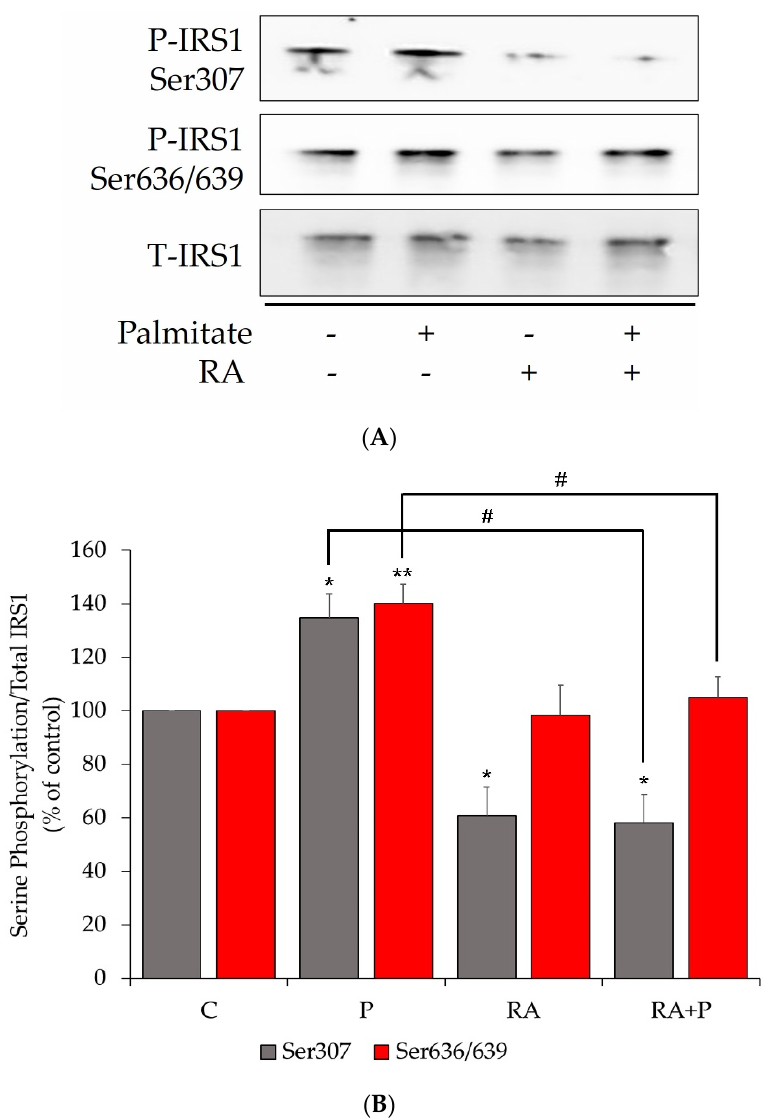
Figure 1. Rosmarinic acid attenuates the palmitate ‐ induced serine (Ser307 and Ser636/639) phosphorylation of muscle cell IRS ‐ 1. Fully differentiated L6 myotubes were treated without (control, C) or with 0.2 mM palmitate (P) for 16 h in the absence or the presence of 5 μ M rosmarinic acid (RA). After treatment, the cells were lysed, and IRS ‐ 1 was immunoprecipitated (IP). The IPs were immunoblotted for phosphorylated Ser 307 and Ser 636/639 or total IRS ‐ 1. Representative immunoblots are shown ( A ). The intensity of the bands (arbitrary units) was measured using Image J software and expressed as percent of control ( B ). The data are the mean ± SE of three separate experiments (* p < 0.05, ** p < 0.01 vs. control, # p < 0.05 vs. palmitate alone).